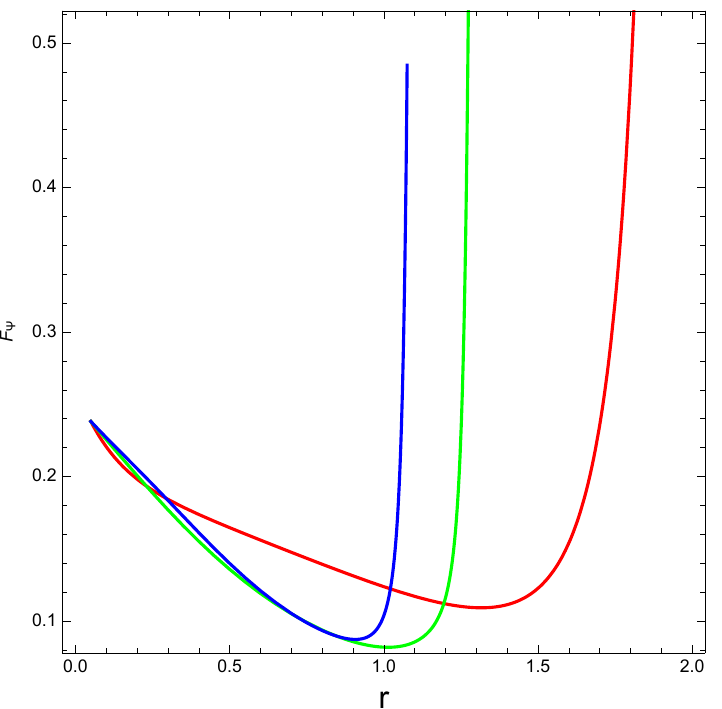
Figure 16. Solution of F ( R ( r )) for R adopted as a linear function of radius. The evolution of partial derivative of f ( R ) is provided by comparing Equation (8) and Equation (33). We have fixed the values of a 0 , a 1 , a 2 , K , and C 1 . The red, green, and blue lines correspond to small perturbations of λ 0 , Ψ 0 , η 1 , η 2 , and η 3 ,